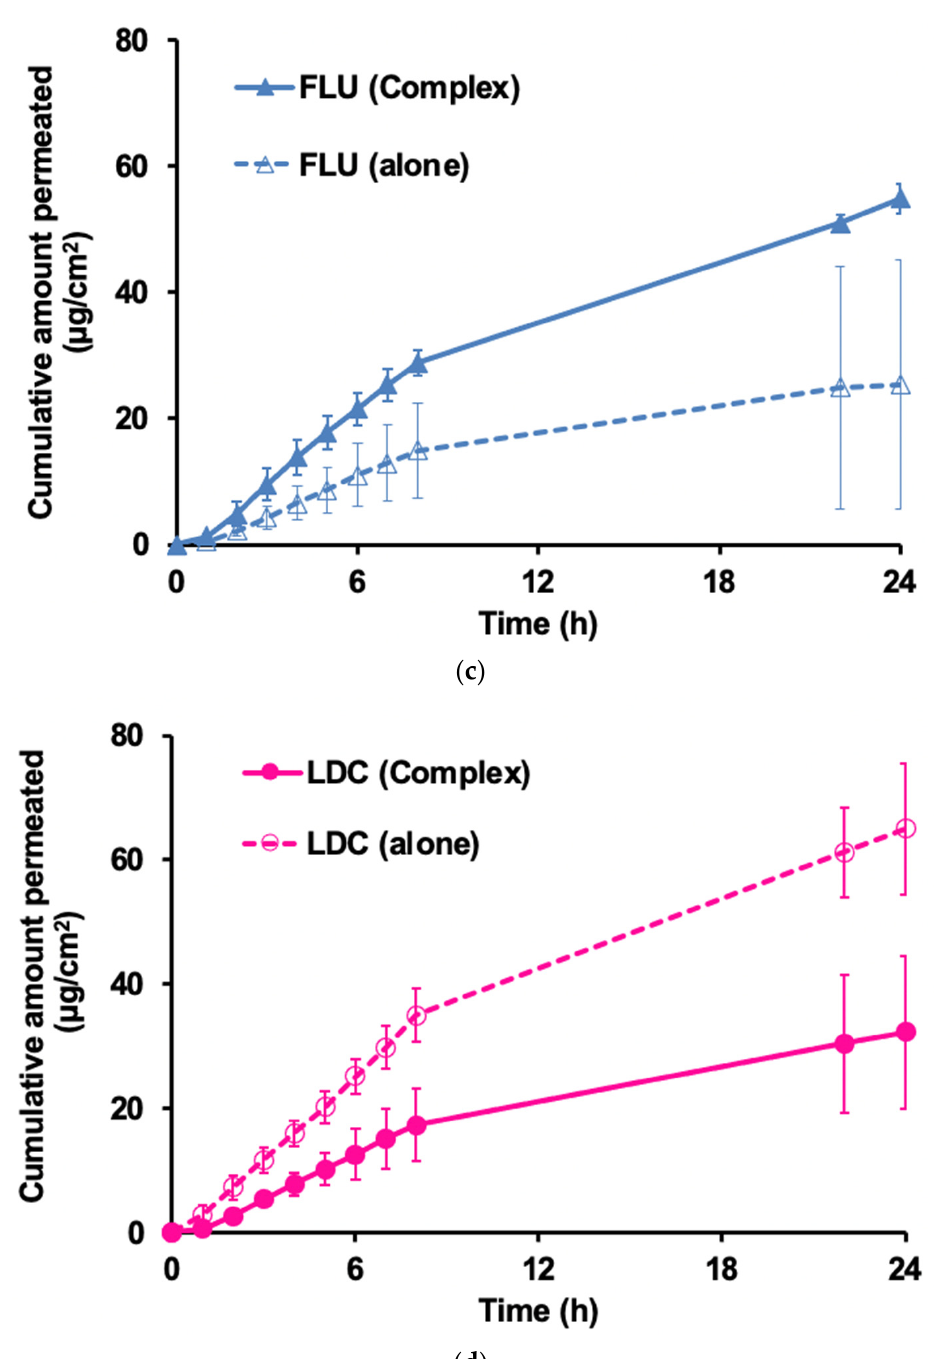
Figure 7. Skin permeation profile of FLU and LDC from the Complex in 2% HPMC gel ( a , b ) and white petrolatum ( c , d ).